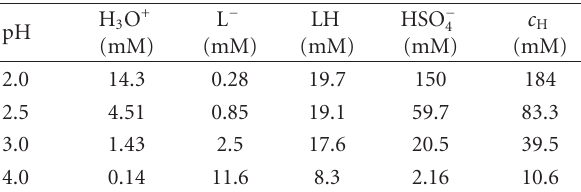
Table 2: Distribution of di ff erent species in the solutions